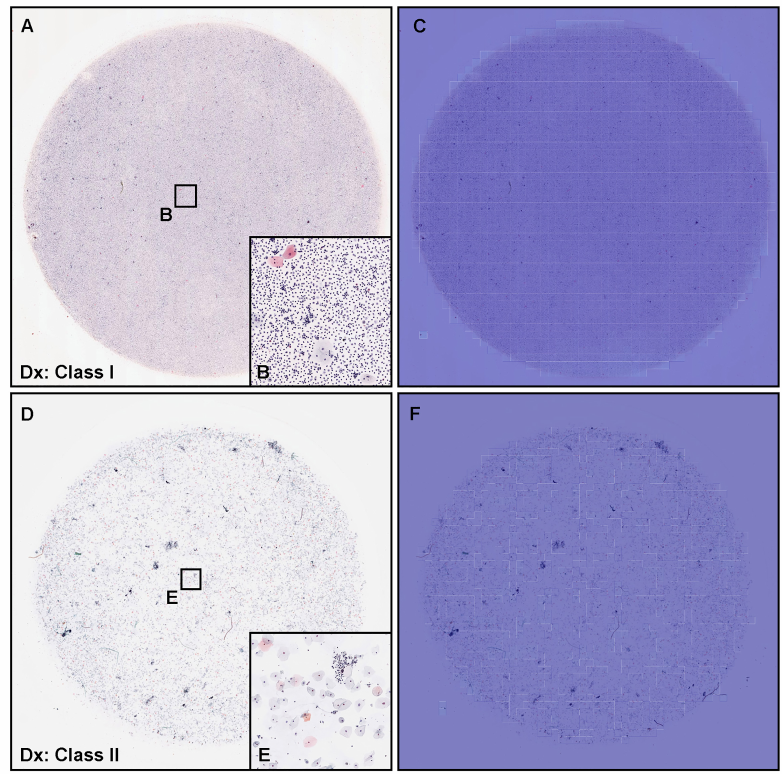
Figure 6. Representative examples of true negative prediction. Two representative examples of neoplastic true negative prediction outputs on urine liquid-based cytology (LBC) whole-slide images (WSIs) from test sets using ENB1-UC-FS+WS model. According to the cytopathological diagnostic (Dx) reports, ( A ) was diagnosed as Class I and ( B ) was Class II, which were negative for urothelial neoplastic epithelial cells. Cytopathologically, ( A ) was pyuria which consisted of infective fluid (pus) with small number of non-atypical epithelial cells ( B ). ( D , E ) included urothelial epithelial cells with slight nuclear enlargement. The heatmap images ( C , F ) show true negative prediction of neoplastic epithelial cells. The heatmap uses the jet color map where blue indicates low probability and red indicates high probability.